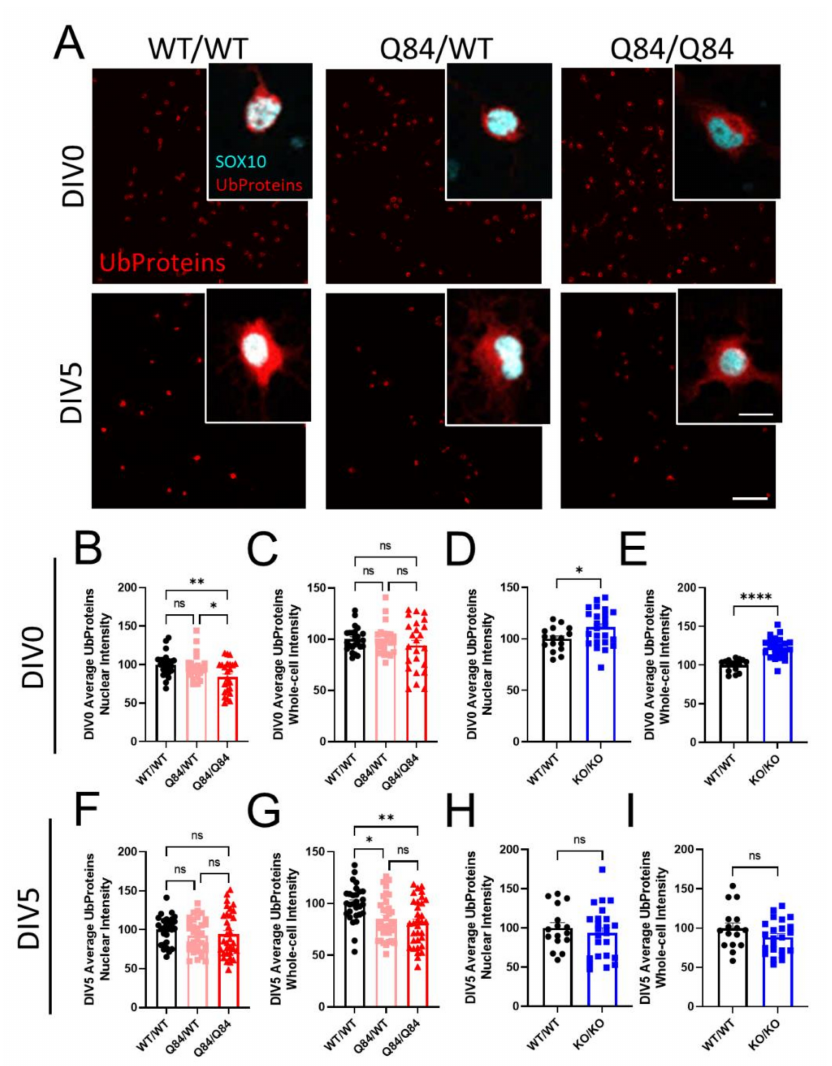
Figure 2. Fewer ubiquitinated proteins are present in SCA3 oligodendrocytes. ( A ) Representative im- munofluorescent images stained for ubiquitinated proteins (red; Ub proteins) and